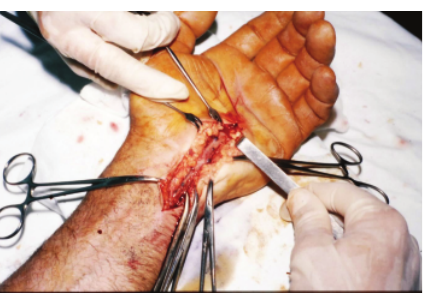
Figure 2: The intraoperative appearance of distal ulnar artery